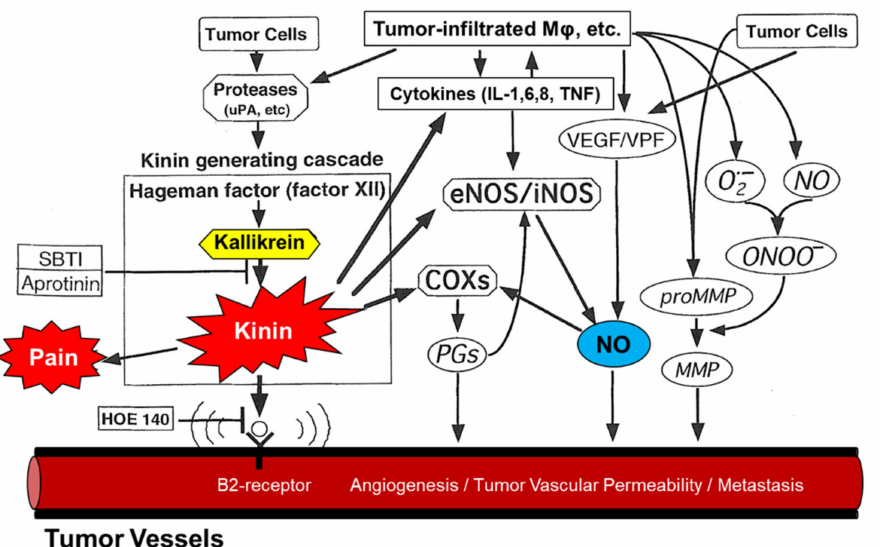
Figure 1. The enhanced permeability and retention (EPR) effect in tumor vasculature. The mechanism of this tumor-selective macromolecular drug targeting depends on various effectors affecting vascular tone, as shown here. Aprotinin is an inhibitor of kallikrein; HOE-140 is a peptide antagonist of kinin. SBTI, soybean trypsin inhibitor; NO, nitric oxide; eNOS, endothelial nitric oxide synthase; iNOS, inducible form of nitric oxide synthase; COXs, cyclooxygenases; PGs, prostaglandins; MMP, metalloproteinase; ONOO − , peroxynitrite; O 2 − , superoxide anion radical; M Φ , macrophage; VEGF, vascular endothelial growth factor; VPF, vascular permeability factor; uPA, urokinase plasminogen activator; IL, interleukin; TNF, tumor necrosis factor; B2 receptor, bradykinin B2 receptor (see also Supplementary Figure S1, adapted from ref